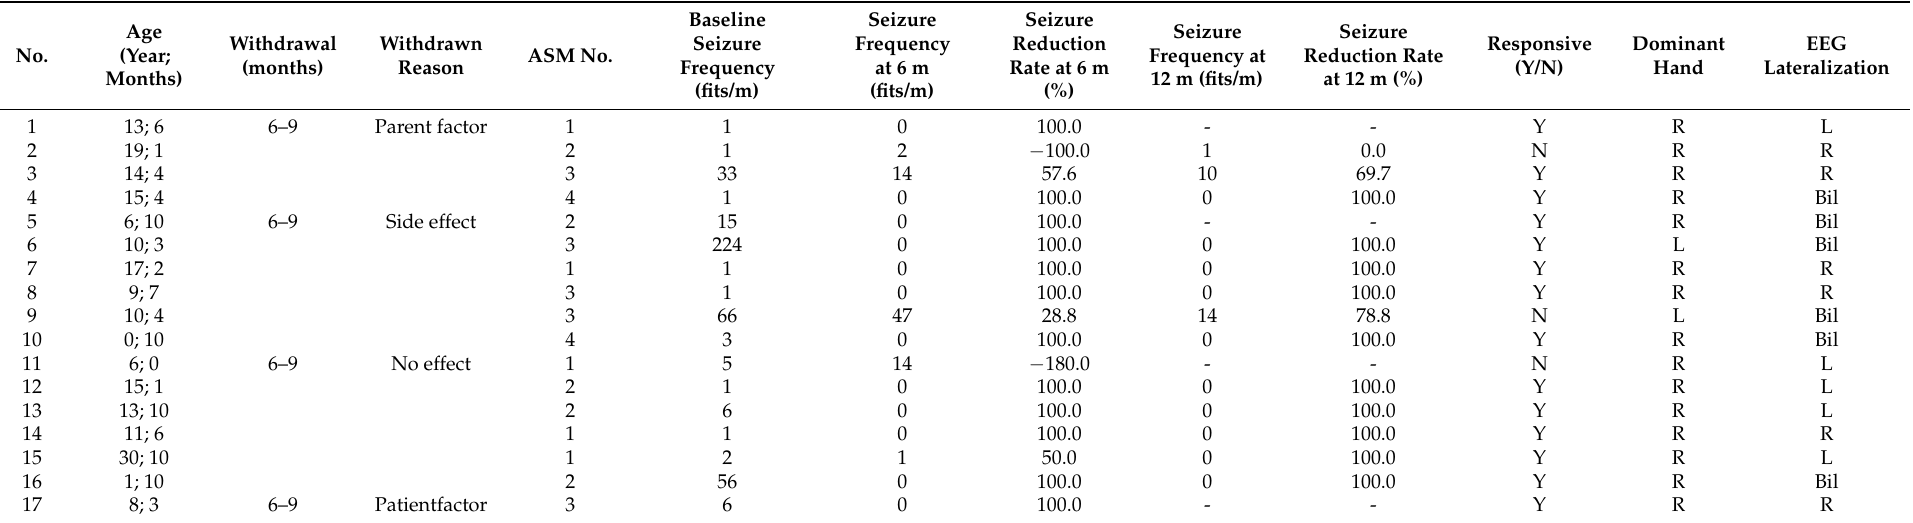
Table 1. Demographic data of study